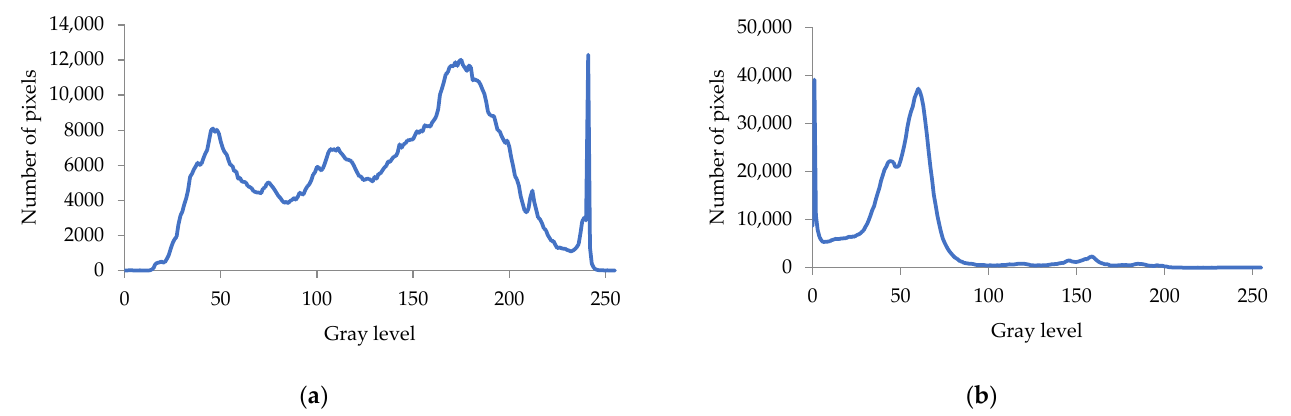
Figure 5. ( a ) Histogram of image in Figure 3c. ( b ) Histogram of image in Figure 3f. The flowchart of the proposed leaf detection and counting method is depicted in Figure 6. It started with the reading of an RGB image. The image size collected from the greenhouse was 1280 × 1024 pixels. The image was resized to 640 × 512 pixels to speed up the process. Then, the image was sharpened using a sharpening filter to enhance the contrast between the objects. The sharpening filter was a spatial filter using a 3 × 3 Laplacian kernel (all elements of the kernel were − 1, except for the center one, which was 9). Recalling the grayscale histograms in Figure 5, it was clear that the grayscale image of the respective RGB image was suitable for the leaf segmentation. Therefore, after sharpening, the RGB image was converted to a grayscale image.